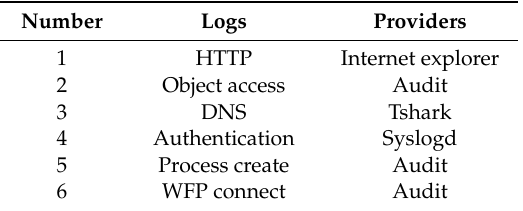
Table 2. Logs used for cyber situation perception comprehension.